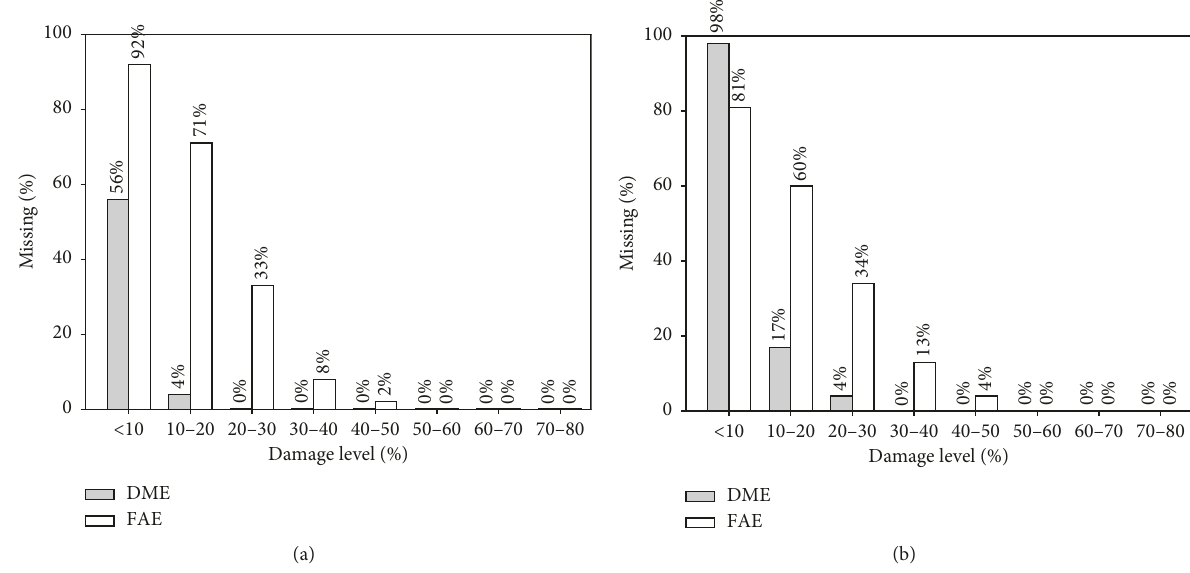
Figure 28: Comparison between the proposed CNN model 2 and the antiresonant frequency-based MLP [27]: DME (a) and FAE